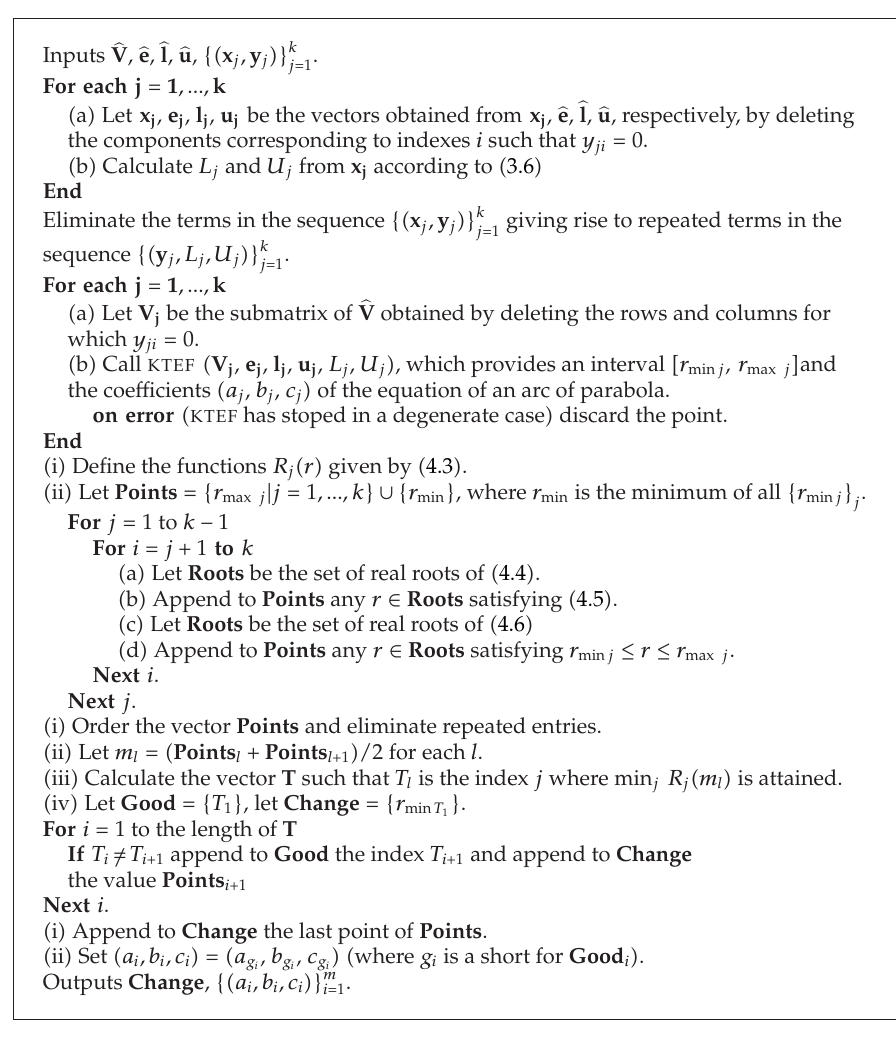
Algorithm 2: The KTEF - S